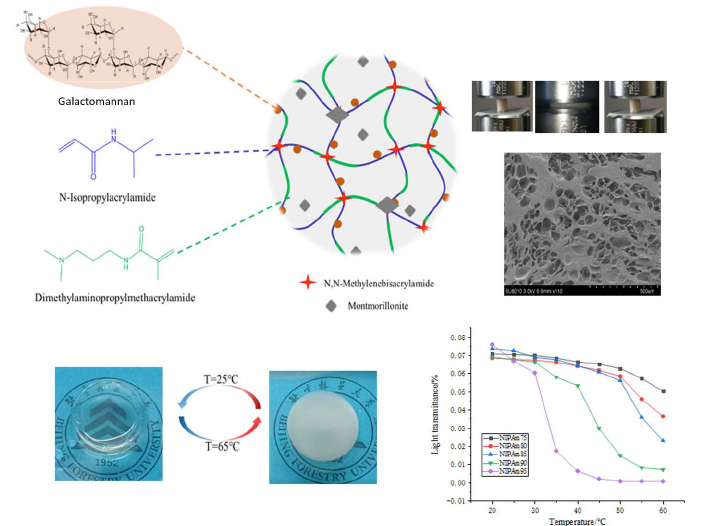
Figure 1. Scheme of the GA–P(NIPAM-co-DMAPMA) hydrogel structure and